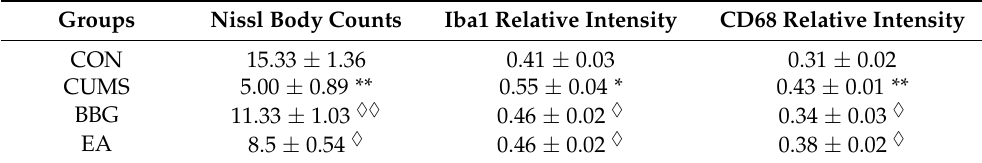
Figure 2. Effects of EA on the PFC: ( A ) microglial morphology, ( B ) Nissl bodies, and ( C ) comparison of Iba1 expression in PFC. Nissl body count of PFC of rats in each group ( D ), comparison of Iba1 expression in PFC in each group ( E ). * p < 0.05, ** p < 0.01. The scale bars in A = 2 µ m, the scale bar in B = 50 µ m, the scale bar in C = 100 µ m. Table 5. Effect of EA on the Nissl body count and expression of Iba1 in PFC and CD68 in right liver lobe of CUMS